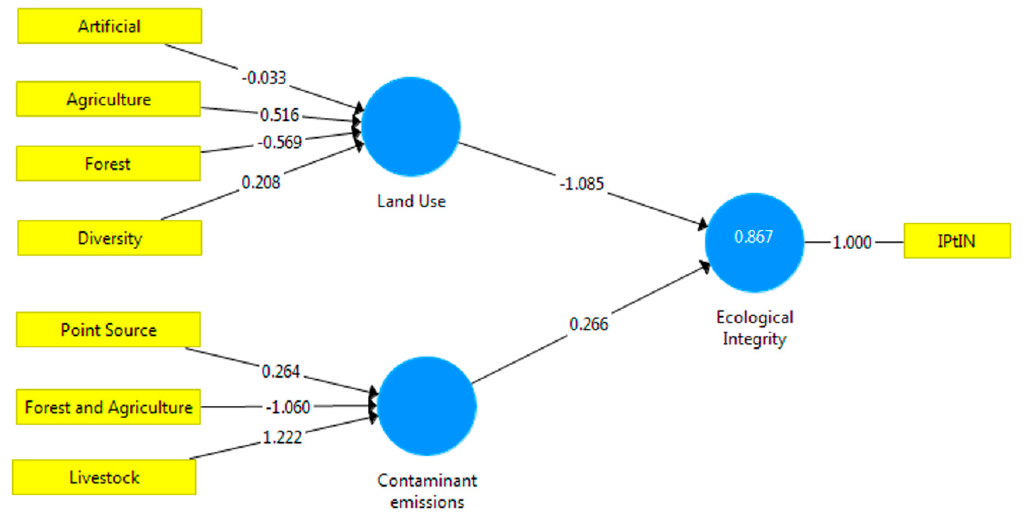
Figure 4. PLS-PM example model.